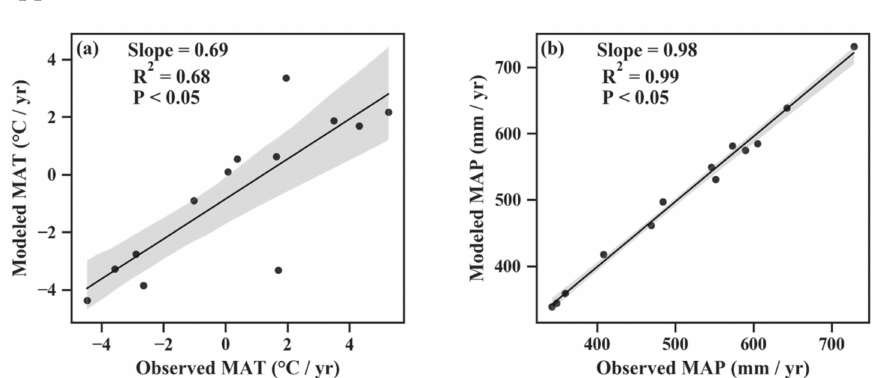
Figure A1. Validation of modeled MAT (Mean Annual Temperature) ( a ) and MAP (Mean Annual Precipitation) ( b ) by using meteorological station data. The shadow regions along the regression line denote 95% confidence interval.